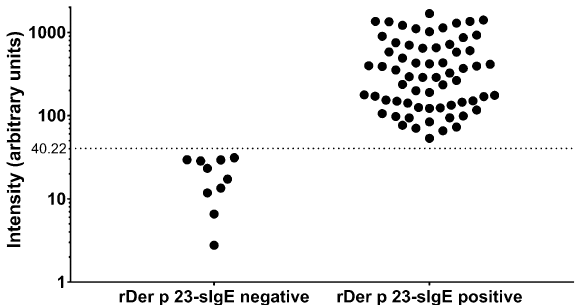
Figure 2. Intensity (arbitrary unit (a.u.)) of rDer p 23-specific immunoglobulin E (sIgE)-negative and sIgE- positive individuals. Individuals with intensity < 40.22 a.u. were defined as rDer p 23-sIgE negative (n = 10). The 65 rDer p 23-sIgE positive individuals have the intensity between and equal to 53.25 a.u. to 1682.41